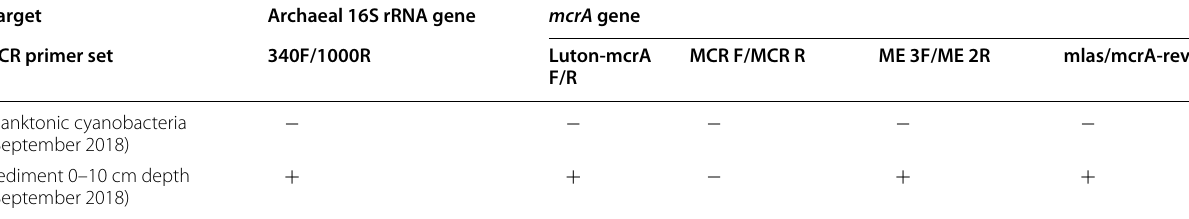
) and ( ), respectively. The annealing temperature for each primer set is listed in Table 4 + −